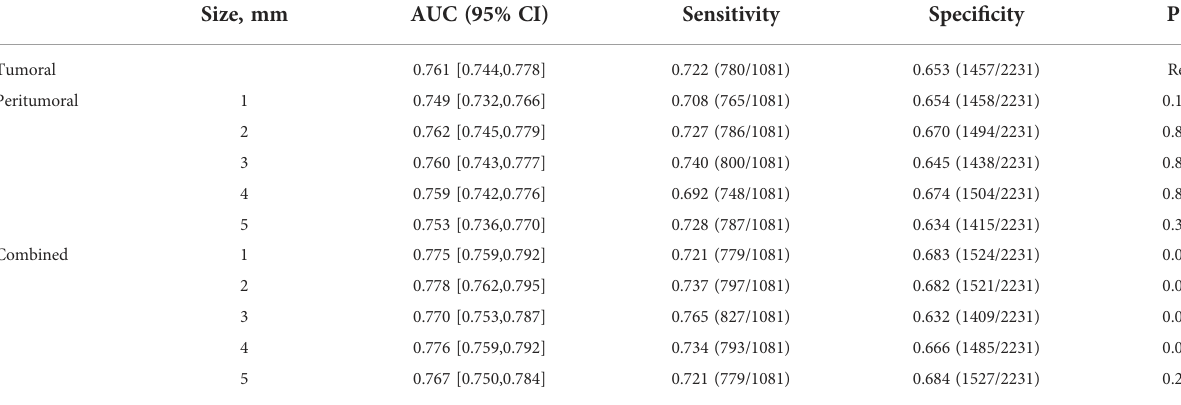
TABLE 3 Benign/malignant classi fi cation performance of radiomics models in ROI level.